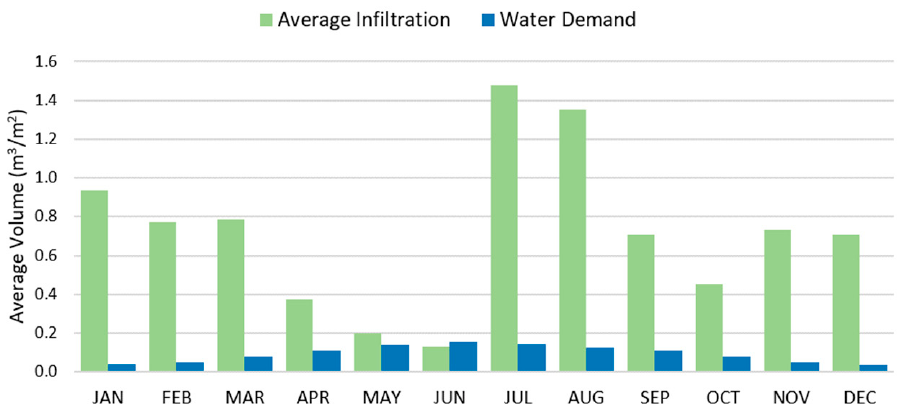
Figure 9. Average infiltrated volumes per square meter of surface area of on-street basins based on the 20-year analysis for configuration CURRENT and estimated irrigation demands per square meter for high water use plants based on calculations from Waterfall (2006).